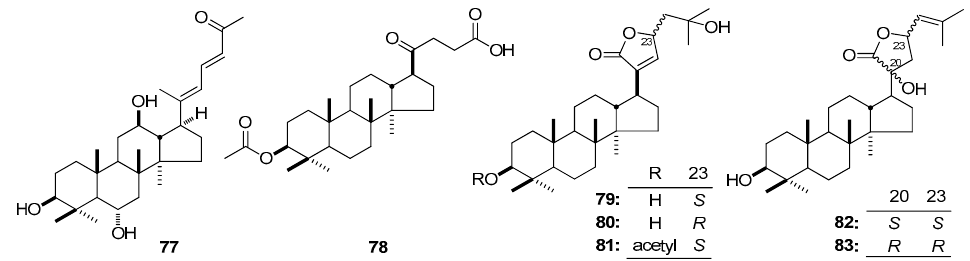
Figure 9. The structure of compounds 77 – 83 .